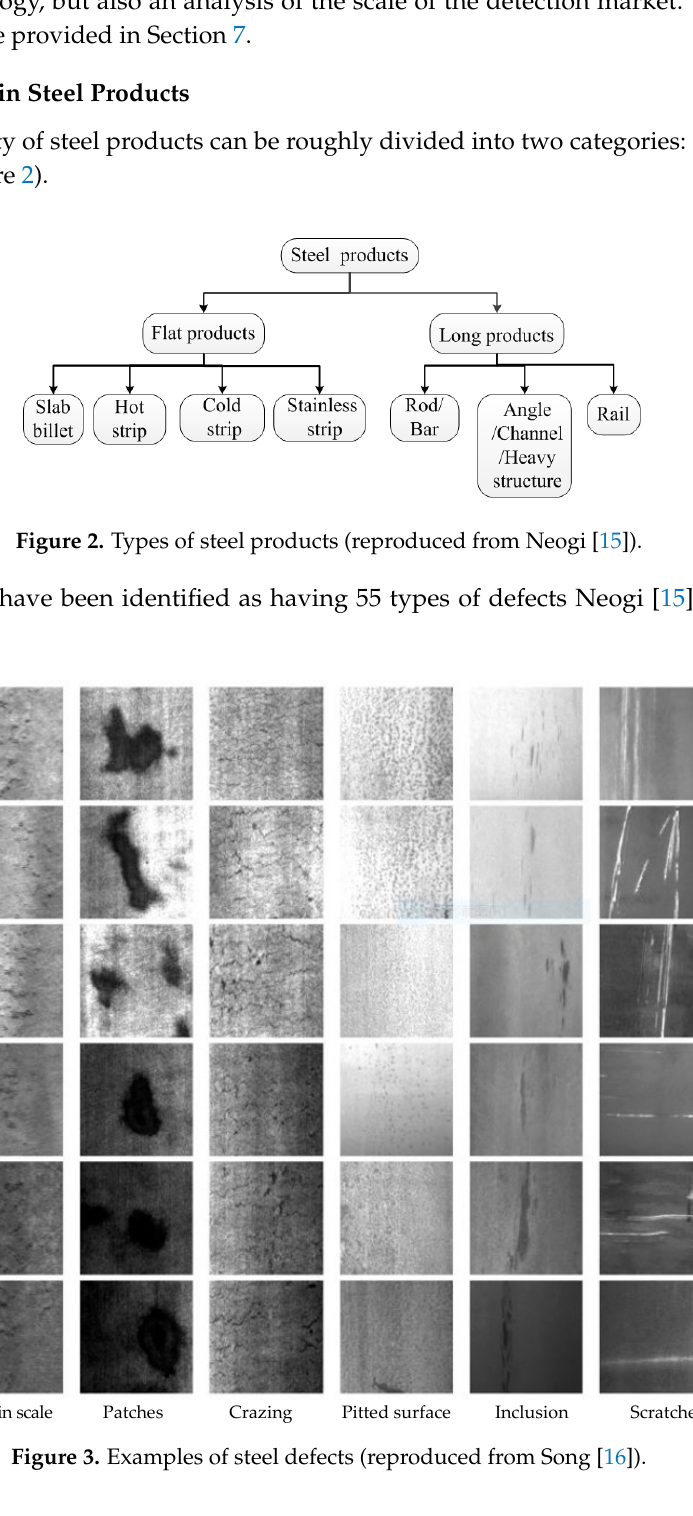
Figure 3. Examples of steel defects (reproduced from Song [16]).